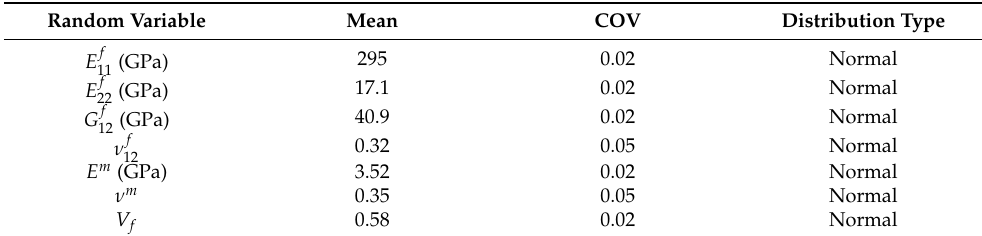
Table 2. Statistics of the constituent’s properties of the T800/X850